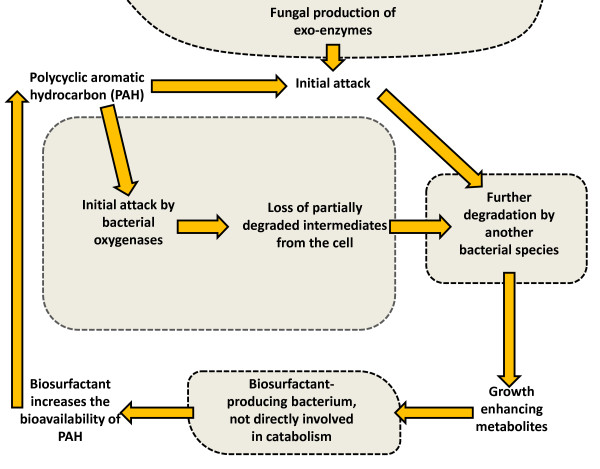
Schematic illustration of some of the interactions seen in a microbial consortium degrading polycyclic aromatic hydrocarbons (PAHs). Different microbial cells are represented by shaded shapes surrounded by a dashed line. Elements of these interactions have been seen in several studies (see text for details). Further complexity can be built into this simple schematic if one considers multiple PAHs invoking several pathways in one or more microbes, as well as co-metabolic degradation.